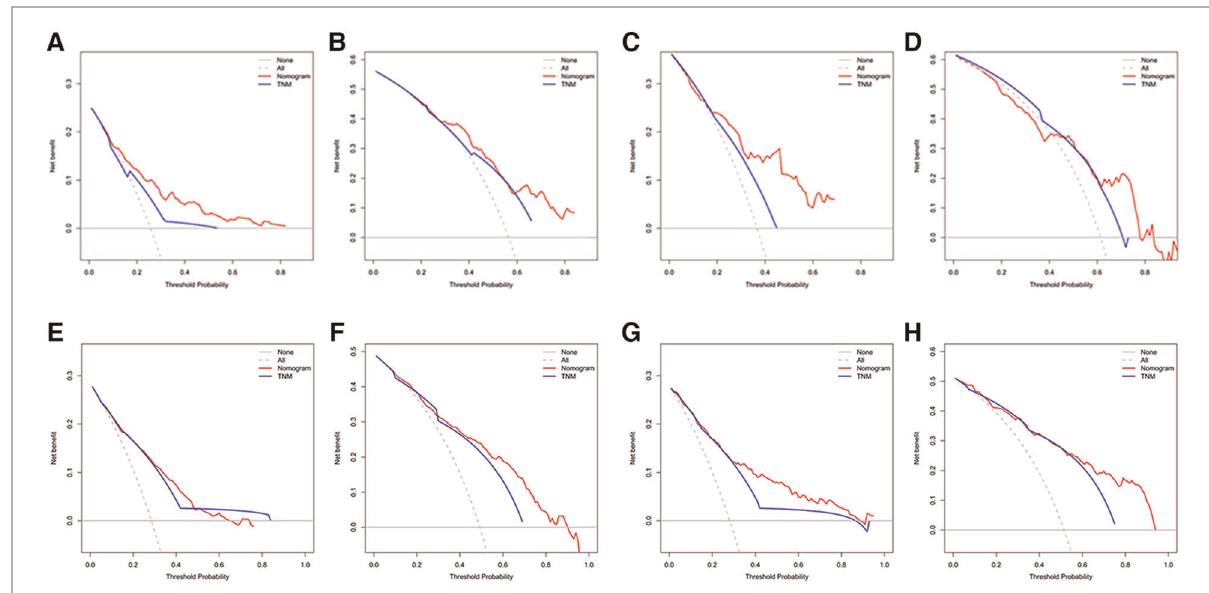
FIGURE 5 ( A ) Decision curve analysis (DCA) of internal validation to predict 3- year OS of chemotherapy cycles <9, ( B ) Decision curve analysis (DCA) of internal validation to predict 5- year OS of chemotherapy cycles <9, ( C ) Decision curve analysis (DCA) of external validation to predict 3- year OS of chemotherapy cycles <9, ( D ) Decision curve analysis (DCA) of external validation to predict 5- year OS of chemotherapy cycles <9, ( E ) Decision curve analysis (DCA) of internal validation to predict 3- year OS of chemotherapy cycles ≥ 9, ( F ) Decision curve analysis (DCA) of internal validation to predict 5- year OS of chemotherapy cycles ≥ 9, ( G ) Decision curve analysis (DCA) of external validation to predict 3- year OS of chemotherapy cycles ≥ 9 and ( H ) Decision curve analysis (DCA) of external validation to predict 5- year OS of chemotherapy cycles ≥